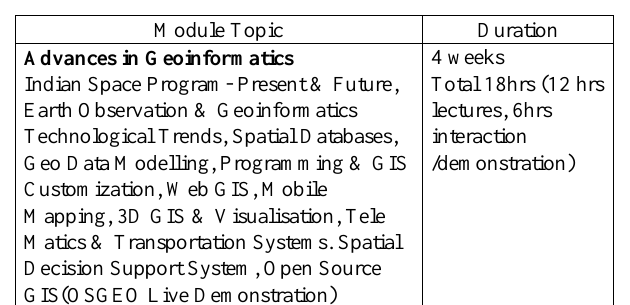
Figure 6. Schematic of LMS based High Quality Streaming using